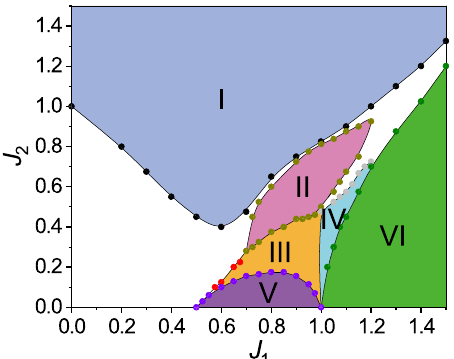
Fig. 1 Structure of a kagome-strip chain. The black solid, red dashed, and blue broken lines denote the exchange interactions J X , J 1 , and J 2 , Fig. 2 Phase diagram of the kagome strip chain at M / M sat = 1/5. M is the respectively. The green circles denote the sites with spin. The numbers magnetization and M sat is the saturation magnetization. Here, J 1 and J 2 are below the vertical dotted lines represent the distance of the sites along the the exchange interactions shown in Fig. 1. The colored regions denote the 1/ x-axis from the left edge. We set J = 1. 5 plateau phases, which are distinguished by Roman numerals and X